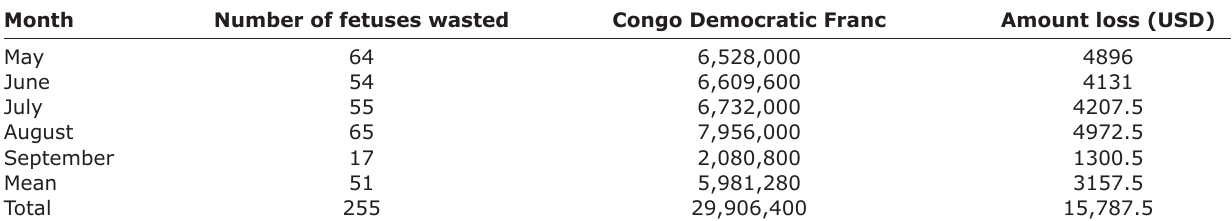
Table-4: Average monthly financial implications of slaughtering pregnant female cows at the ELAKAT provincial